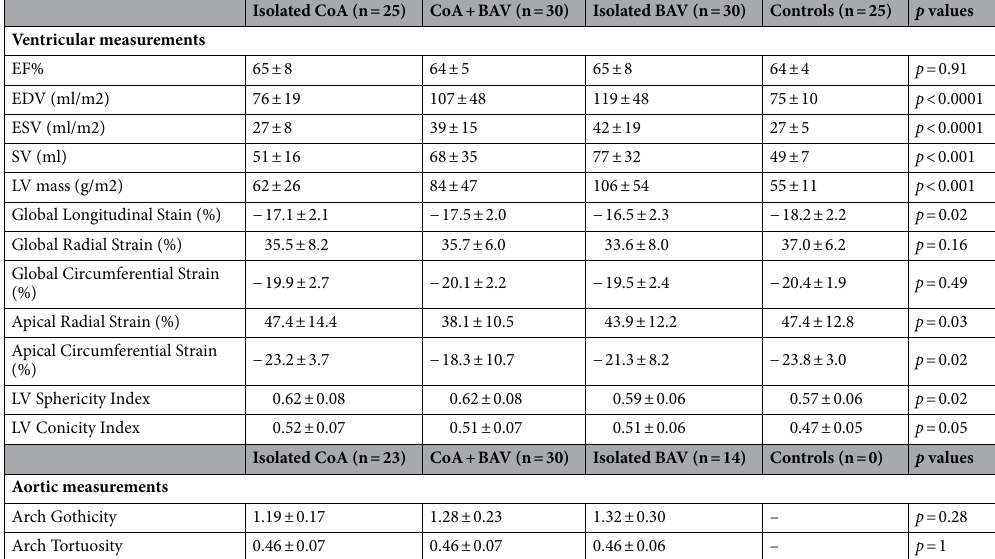
Table 2. CMR measurements. Controls lacked the sequence for 3D aortic reconstructions and therefore arch measurements were not available. EF ejection fraction, EDV end-diastolic volume, ESV end-systolic volume, SV stroke